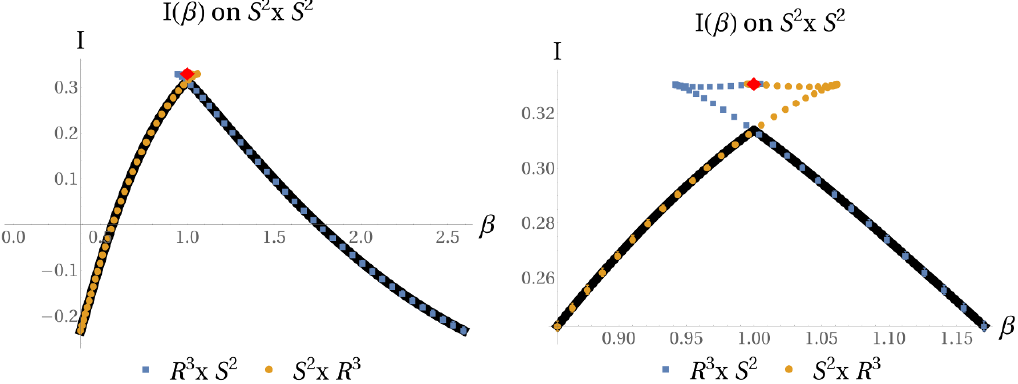
Figure 6 . The action I as a function of the ratio of radii (cid:12) for both topologies with conformal boundary S 2 (cid:2) S 2 . The red diamond is the analytical calculation for the singular ratio (cid:12) s = 1, and the black line follows the dominant solution for each ratio (cid:12) . We see that there is a (cid:12)rst order phase transition at (cid:12) c = 1.